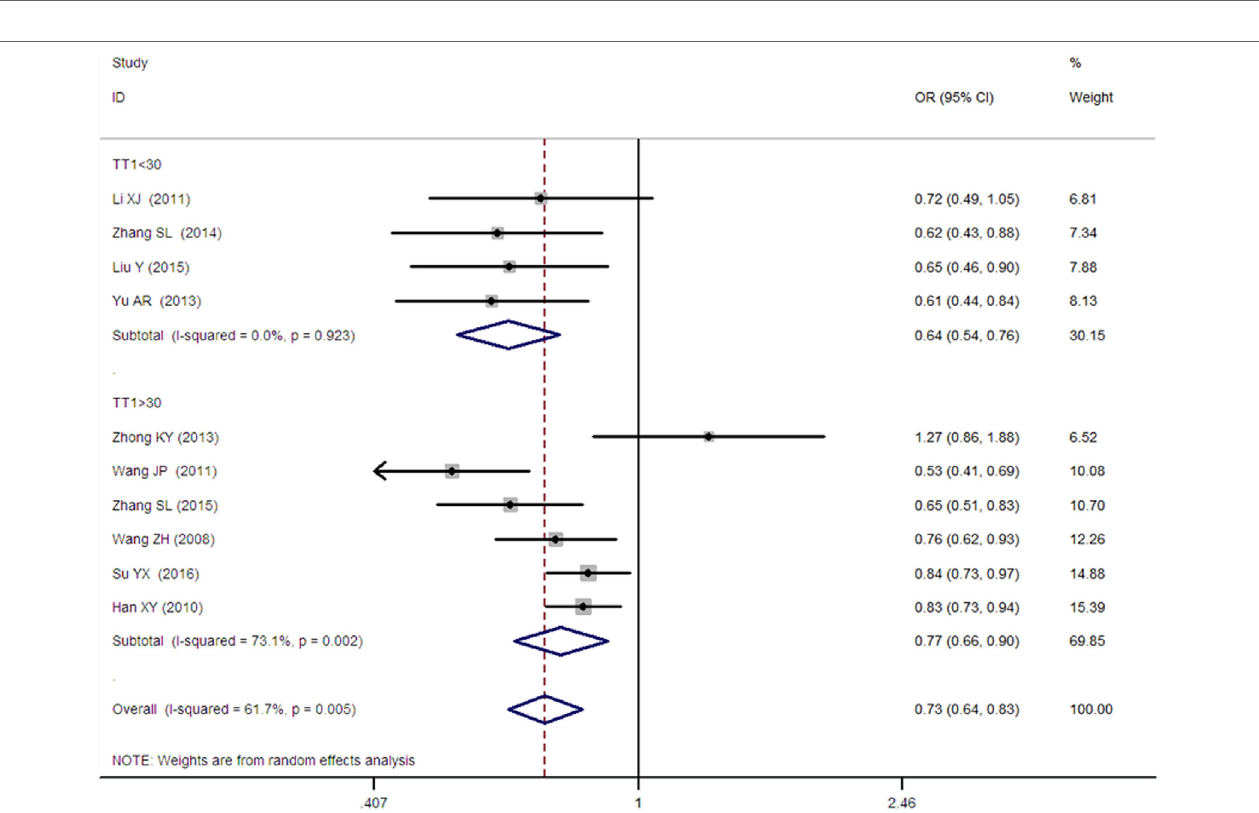
FiGURe 5 | Forest plot of type 2 diabetes mellitus associated with SLC30A8 gene rs13266634C/T in the Chinese population under a heterozygous genetic model (CT vs. CC).